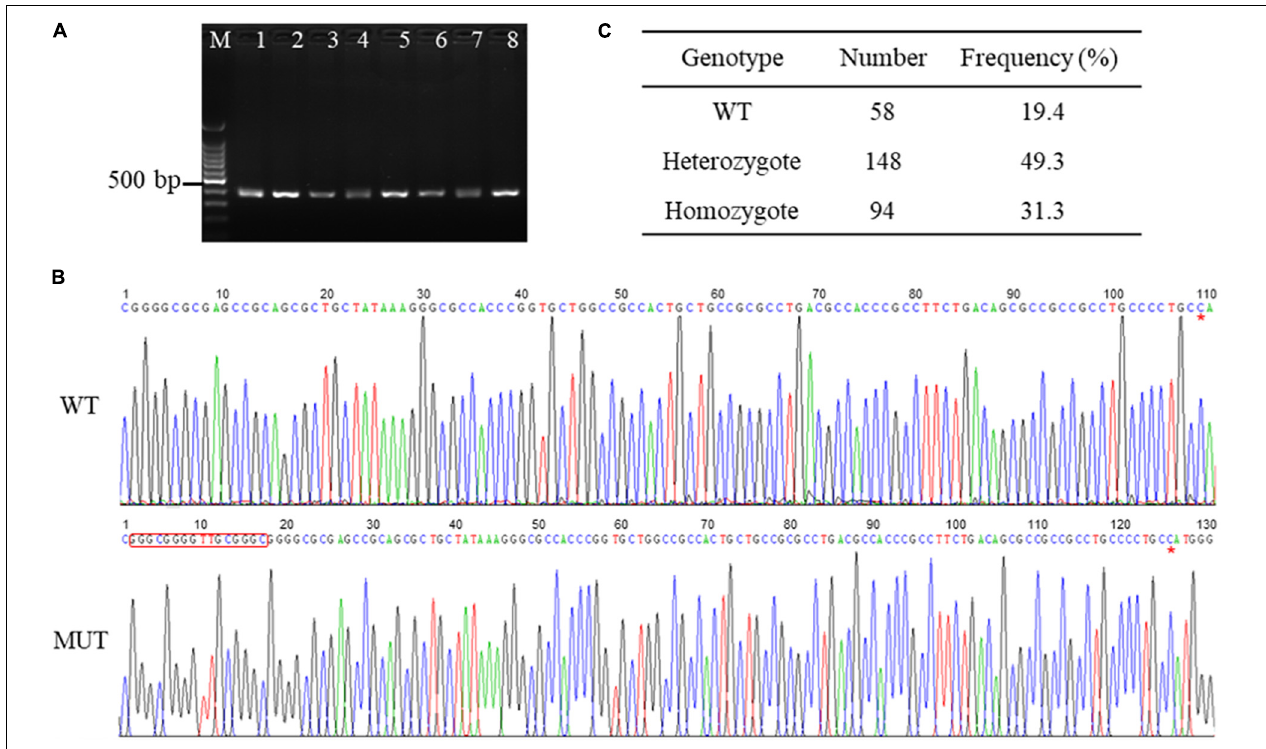
FIGURE 1 | SNPs in the promoter region of AQP3 gene. (A) PCR products of the promoter region of AQP3 gene checked by agarose gel. M: 100 bp ladder; 1–8 represent PCR products from different samples. (B) SNPs identified by PCR sequencing. WT, wild type sequence; MUT, mutant sequence. The inserted sequences are marked with a red box. Red asterisk indicates the starting base of the AQP3 gene. (C) Genotype frequency of the insertion mutation in the Large White pigs.